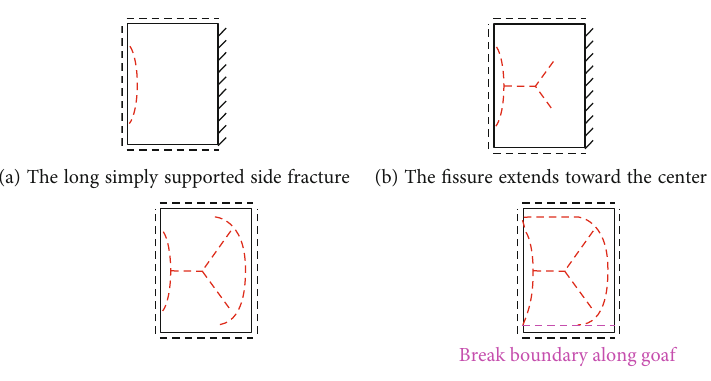
Figure 8: Fracture evolution process of mutative mining stope